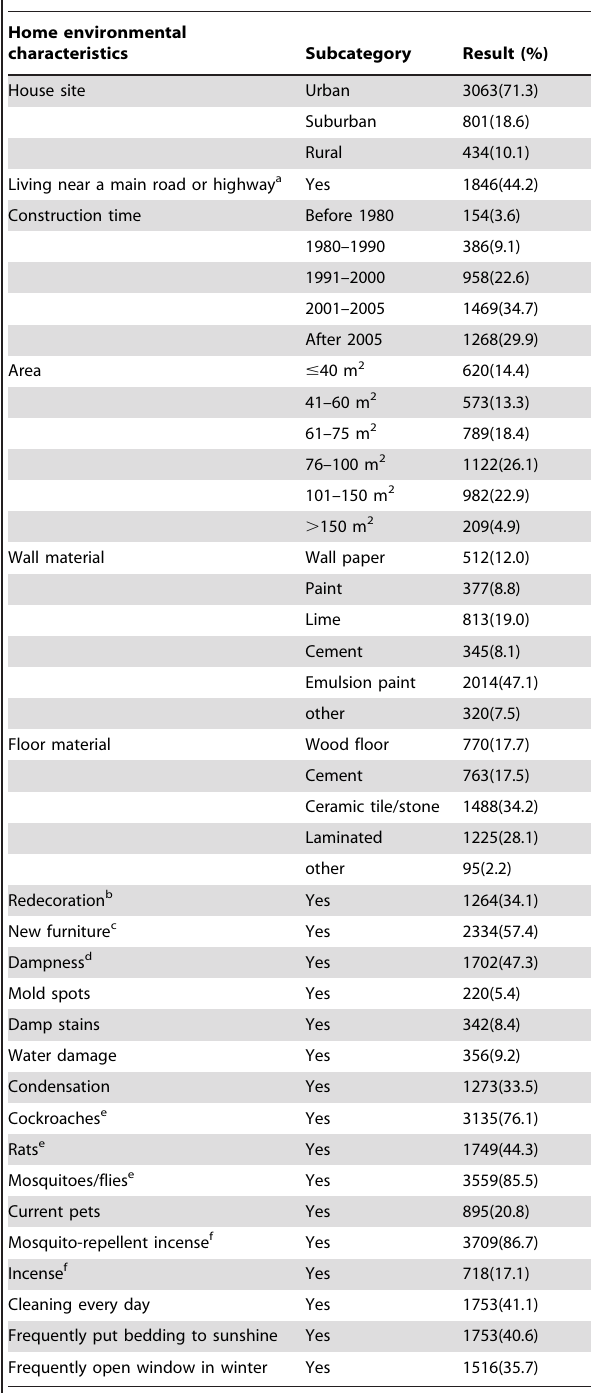
Table 2. Home environmental characteristics of participating parents